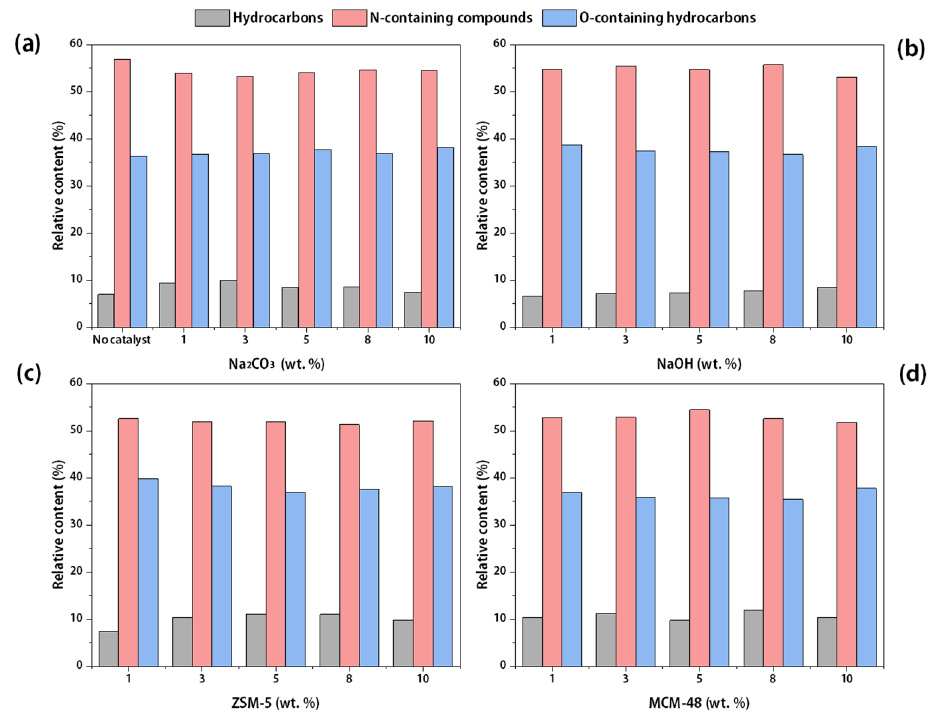
Figure 3. Distribution of hydrocarbons, N-containing compounds and O-containing compounds in bio-oil: ( a ) Na 2 CO 3 , ( b ) NaOH, ( c ) ZSM-5, ( d ) MCM-48.